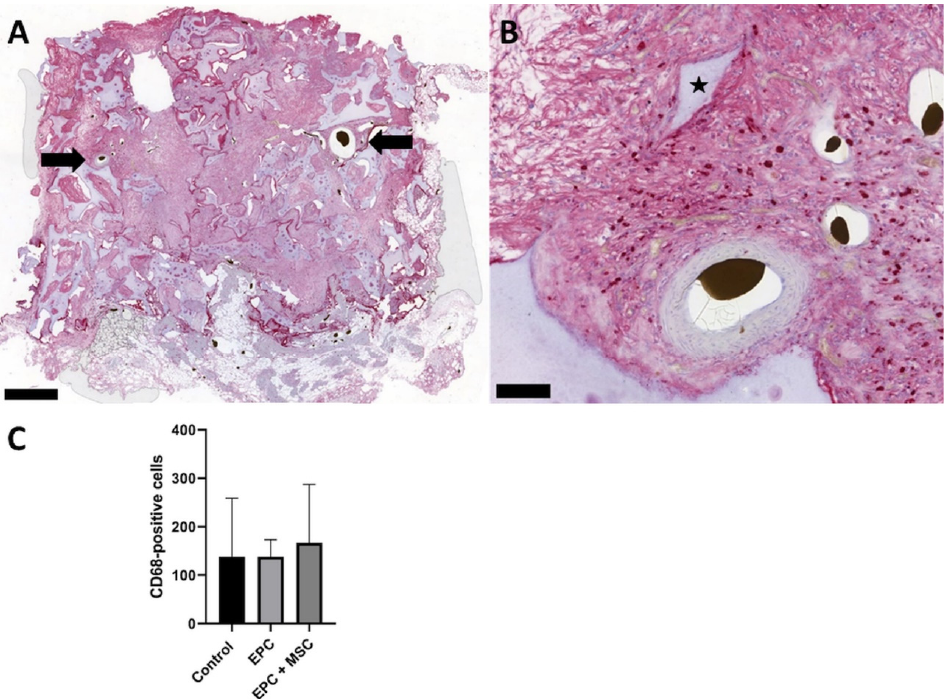
Figure 3. Macrophage staining. Using an anti-CD68 antibody, macrophages were visualized in the constructs. Macrophages are red-stained ( A , B ). Equal numbers of CD68-positive cells were found in all three groups ( C ). The cell-free group is indicated as “control”. Because no differences between the groups exist, exemplary histological slices from group B are demonstrated. Bold bars indicate the AV loop and the black star indicates the HA/ß–TCP granula. Scale bar = 1 mm ( A ) and 100 µ m ( B ).